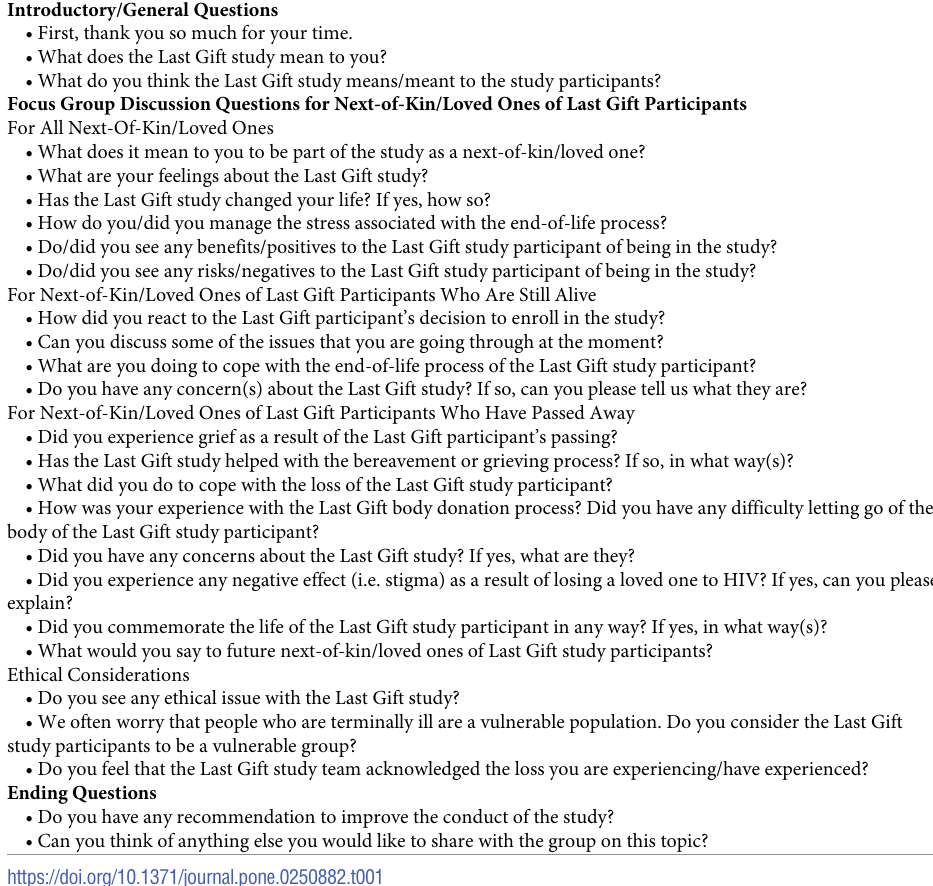
Table 1. Small focus group question route with next-of-kin/loved ones of last gift study participants (Southern California, 2019). Introductory/General Questions • First, thank you so much for your